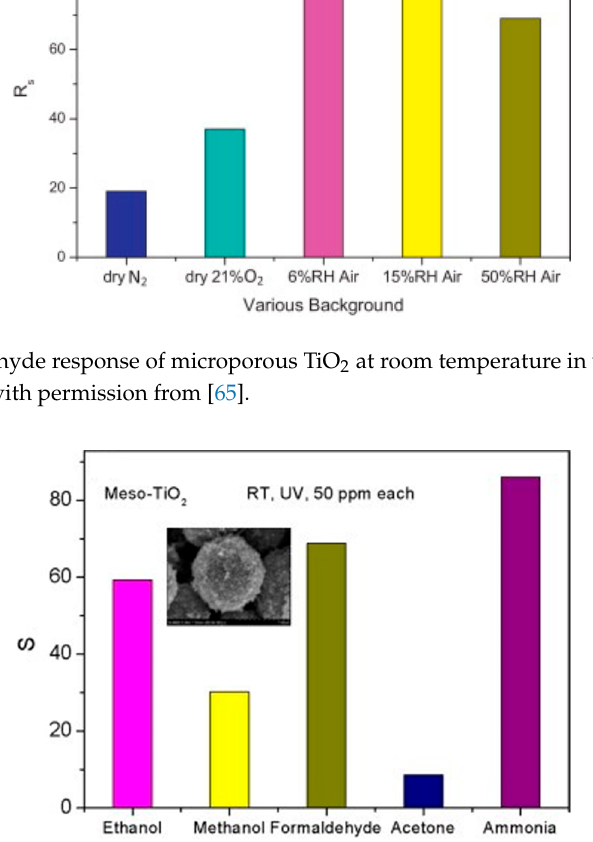
Figure 38. Response of mesoporous TiO 2 towards various organic volatile compounds (VOCs) in 40% humid air at room temperature with UV illumination. Inset is the SEM of mesoporous TiO 2 microspheres. Reproduced with permission from [66].